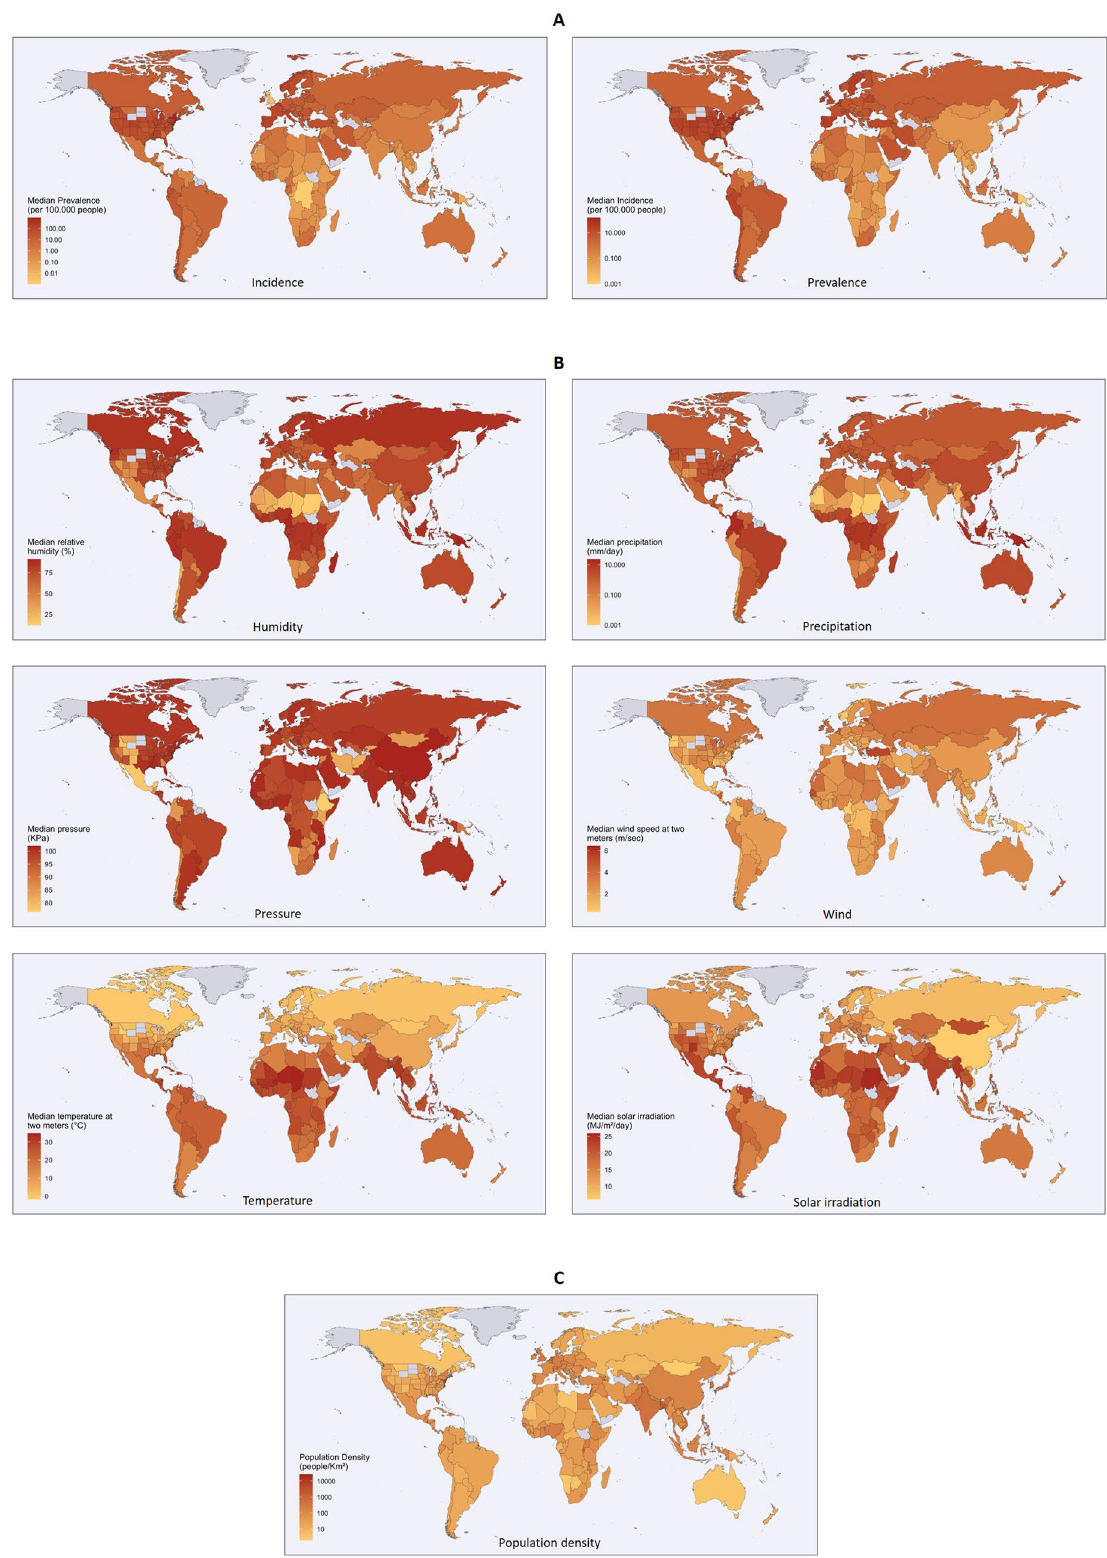
Figure 1. World countries maps. ( A ) Median values of incidence and prevalence of COVID-19. ( B ) Median values of the climatic variables. ( C ) Population density. In grey, countries not recorded. The maps were generated using R software (version 4.0.2—https:// www.r- proje ct. org/), ggplot2 library (version 3.3.2—https:// CRAN.R- proje ct. org/ packa ge= ggplo t2) and Maps (version 3.3.0—https:// CRAN.R- proje ct. org/ packa ge=